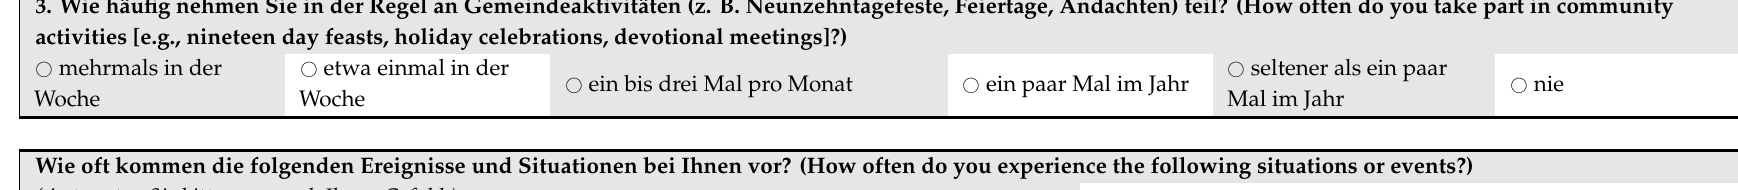
3. Wie häufig nehmen Sie in der Regel an Gemeindeaktivitäten (z. B. Neunzehntagefeste, Feiertage, Andachten) teil? (How often do you take part in